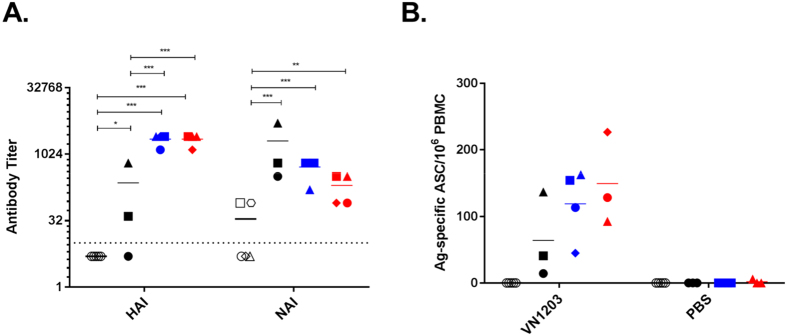
Antibody responses at the time of euthanasia or on day 7 post-challenge with wild-type A/Viet Nam/1203/2004 (H5N1). (A) Hemagglutinin (HA) and neuramidase (NA)-inhibiting-antibody titers as assayed by hemagglutination-inhibition (HAI) assay and enzyme-linked lectin assay (ELLA). (B) Number of H5-specific antibody-secreting cells in the peripheral blood as assayed by B-cell ELISPOT. Of note, we did not recover sufficient cells for one ferret in the AS03 group, and thus only 3 data points were available for this group. *p < 0.05, **p < 0.01, and ***p < 0.001 by one-way ANOVA. Individual ferrets are assigned its respective symbol within its vaccine group (colored as ○ for naïve, ● for unadjuvanted,  for MF59 and for AS03).